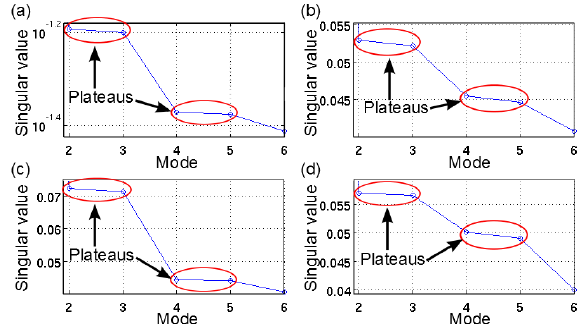
Fig. 14. Singular value spectra (in percentage) with the 24 modes. (a) Nakuru, (b) Naivasha, (c) Narok, and (d) Kisumu. The 1st mode of each result shows the highest rate which means the most domi- nant mode. Fig. 15. Singular value spectra (in percentage) between the 2nd mode and the 6th mode magnified from Fig. 14. (a) Nakuru, (b) Naivasha, (c) Narok, and (d) Kisumu. In all the stations, there are two pairs between the 2nd and the 3rd modes and between the 4th and the 5th modes (red ellipses). Fig. 19. IOD and the two representative time series (trend and har- monics) of the monthly precipitations from 1950 to 1985. This study focuses on the events of IOD around the early 1960’s show- ing the change from the negative mode to the positive mode. At that time, the precipitations in all the stations immediately increased ac- cording to the trend time series and the periodicity is changed from 12-month cycle to 6-month cycle in Nakuru, Naivasha, and Kisumu according to the harmonics time series (see table 5). Table 5. Monthly periodicities every five years of the representative harmonics time series [month] from 1950 to 1984. The main peri- odicities in Nakuru, Naivasha, and Kisumu transiently change from annual cycle to semiannual cycle in the 1960’s. Time region Nakuru Naivasha Narok Kisumu 1950–1954 11 : 9 11 : 9 11 : 9 5 : 9 1955–1959 11 : 9 11 : 9 11 : 9 11 : 9 1960–1964 5 : 9 5 : 9 11 : 9 5 : 9 1965–1969 11 : 9 5 : 9 11 : 9 5 : 9 1970–1974 11 : 9 11 : 9 11 : 9 5 : 9 1975–1979 11 : 9 11 : 9 11 : 9 11 : 9 1980–1984 11 : 9 5 : 9 5 : 9 5 : 9